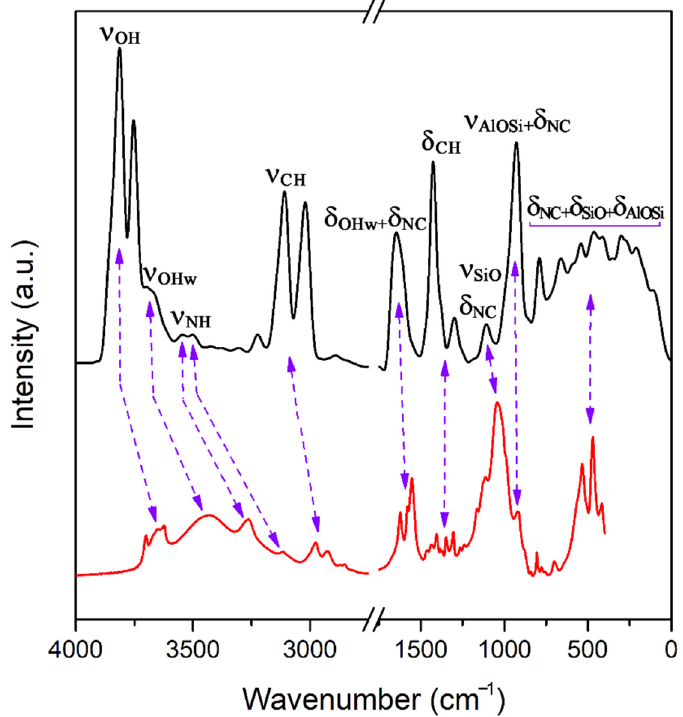
Figure 13. Comparison of the FTIR spectra (red) and the calculated total VDOS (black) in A-TMP-